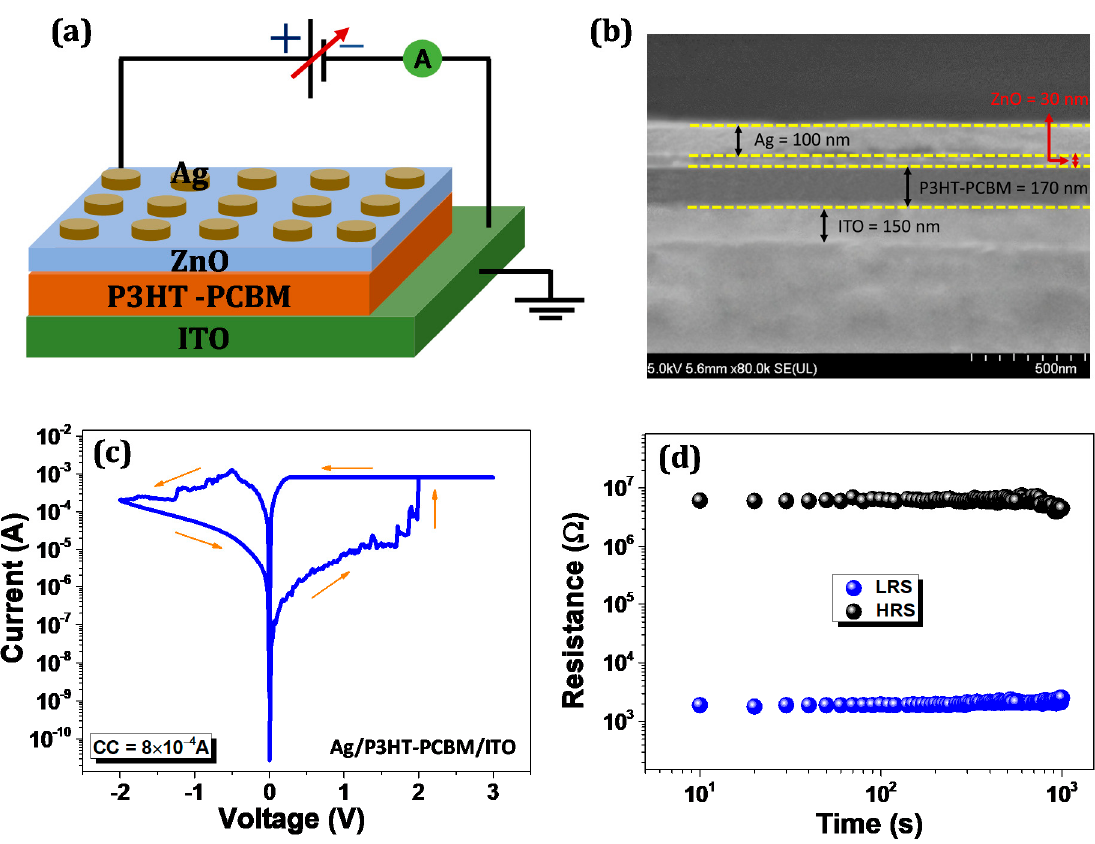
Figure 1. ( a ) Schematic layout of fabricated device with the measurement configuration; ( b ) Cross-sectional SEM image of sandwich structure; ( c ) Typical I-V curve of Ag/P3HT-PCBM/ITO in semi-logarithmic scale; ( d ) Retention characteristic in both high resistance state (HRS) and low resistance state (LRS).